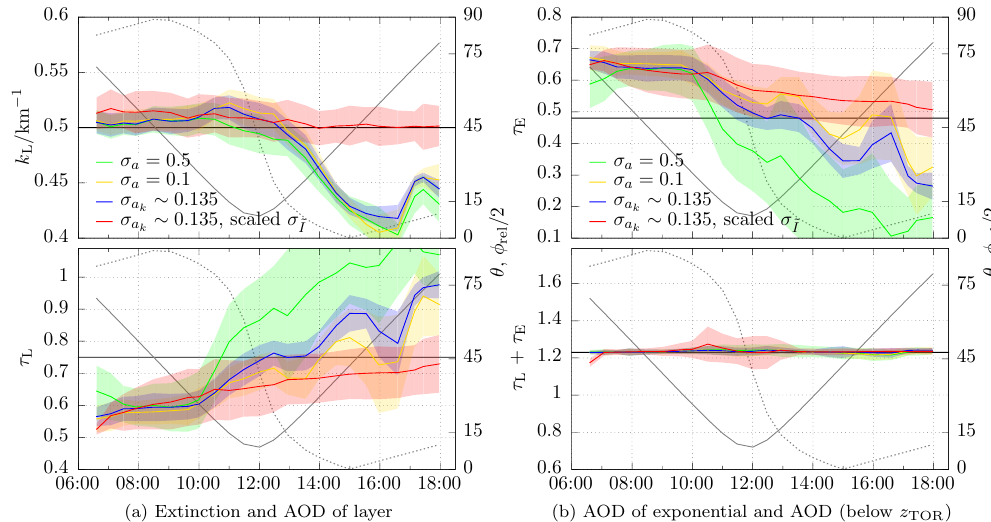
Fig. 14. As Fig. 11, but here with relative intensities ˜ I , for different choices of the regularisation parameter (fixed and according to Eq. 19) and σ ˜ scaled according to Eq. (20) in one case (red I